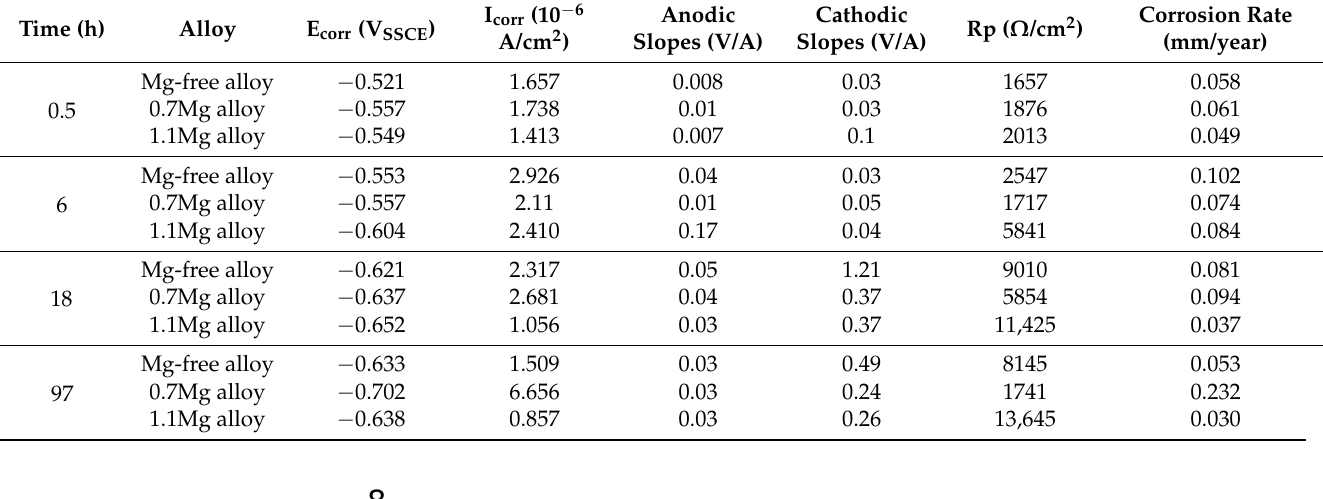
Table 2. E corr and I corr values of Al–Cu–Li– x Mg alloys extracted from potentiodynamic polarization studies in Figure 2.